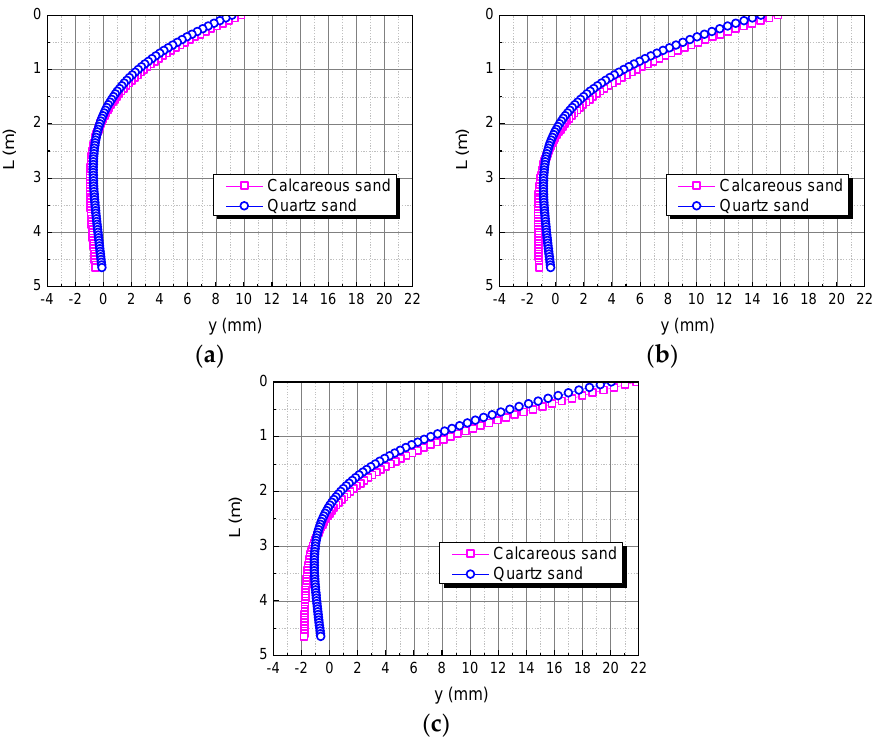
The bending moment is taken as M, 2M, and 3M, respectively. The influence of the bending moment on the horizontal displacement of the pile body is shown in Figure 16. When the bending moment is M, the horizontal displacement of the pile top of the pile foundation in the calcareous sand area is 0.63122 mm larger than in quartz sand area. When the bending moment is 2M, the horizontal displacement of the pile top in the cal- careous sand area is 0.69065 mm larger than in the quartz sand area. When the bending moment is 3M, the horizontal displacement of the pile top in the calcareous sand area is 0.75007 mm larger than in the quartz sand area. The greater the bending moment, the greater the difference between the two. It may be because the greater the bending mo- ment, the greater the force per unit area, which makes calcareous sand easier to com- press than quartz sand.